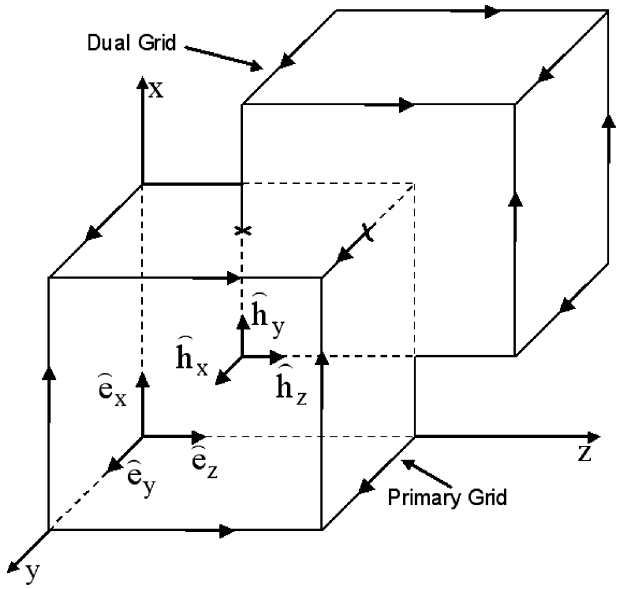
FIG. 2. The allocation of electric and magnetic field compo- nents on the grid